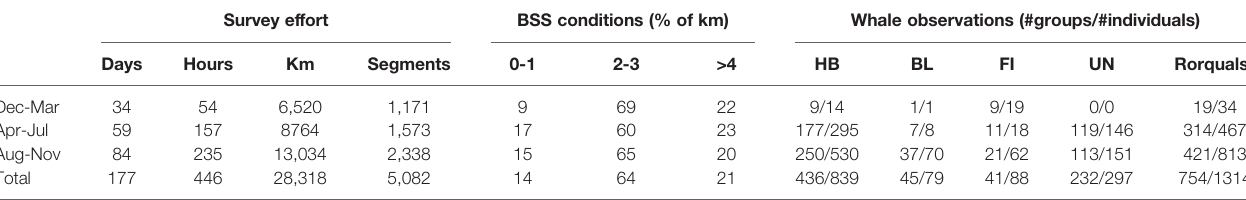
TABLE 1 | Research effort and whale observations from helicopter and shipboard surveys, September 2016 to September 2021. Survey